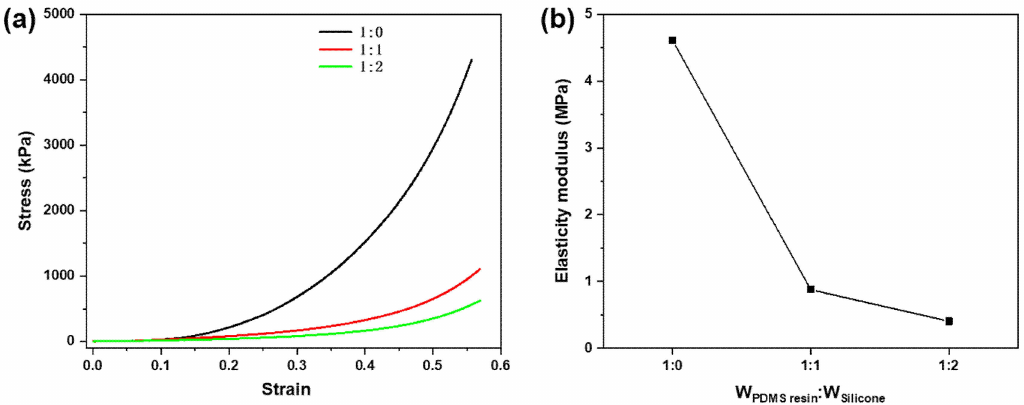
Figure 9. ( a ) Compressive stress–strain curves and ( b ) compressive elastic modulus values of di ff erent samples.